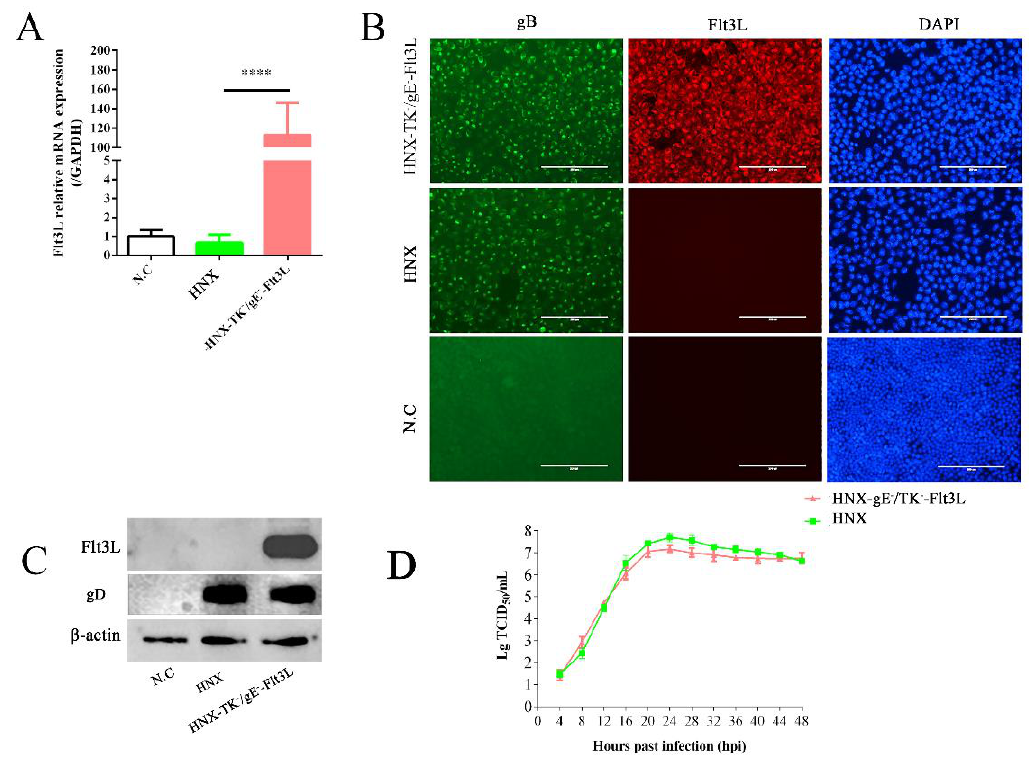
Figure 3. Characterization of the recombinant HNX-TK − /gE − -Flt3L. ( A ) Detection of the transcription of the Flt3L gene in HNX-TK − /gE − -Flt3L virus- and HNX-infected cells through RT-qPCR (**** < 0.001). ( B ) Detection of the Flt3L protein and viral gB protein expression through an immunofluorescence assay (IFA). Green: gB-positive cells; red: Flt3L-positive cells; blue: DAPI-stained PK-15 cell nucleus. DAPI, 4’,6-diamidino-2-phenylindole. ( C ) Western blot analysis of β -actin, gD, and Flt3L of the PK-15 cells infected with HNX-TK − /gE − -Flt3L, HNX, or DMEM as a control. ( D ) One step growth curves of HNX-TK − /gE − -Flt3L and HNX in PK-15 cells.